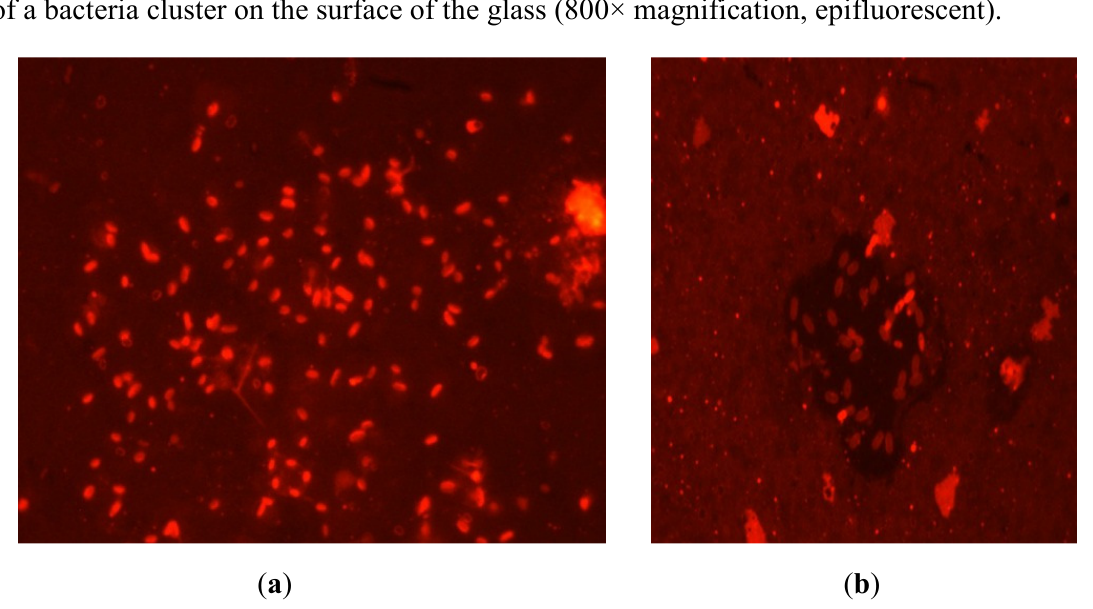
Figure 5. ( a ) Bacteria (white objects) attached to the surface of the glass after 3 days of pumping water through the system (400× magnification, epifluorescent); and ( b ) close up